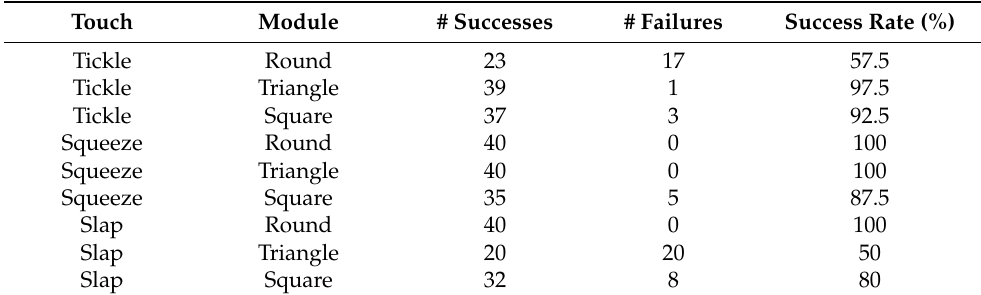
Table 1. The three touches on all shape success